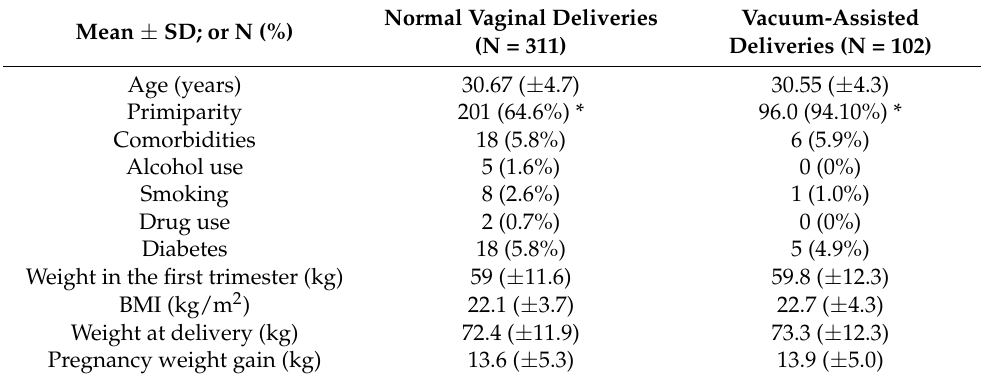
Table 2. Comparison of women with OASIS according to the mode of delivery. Mean ± SD; or N